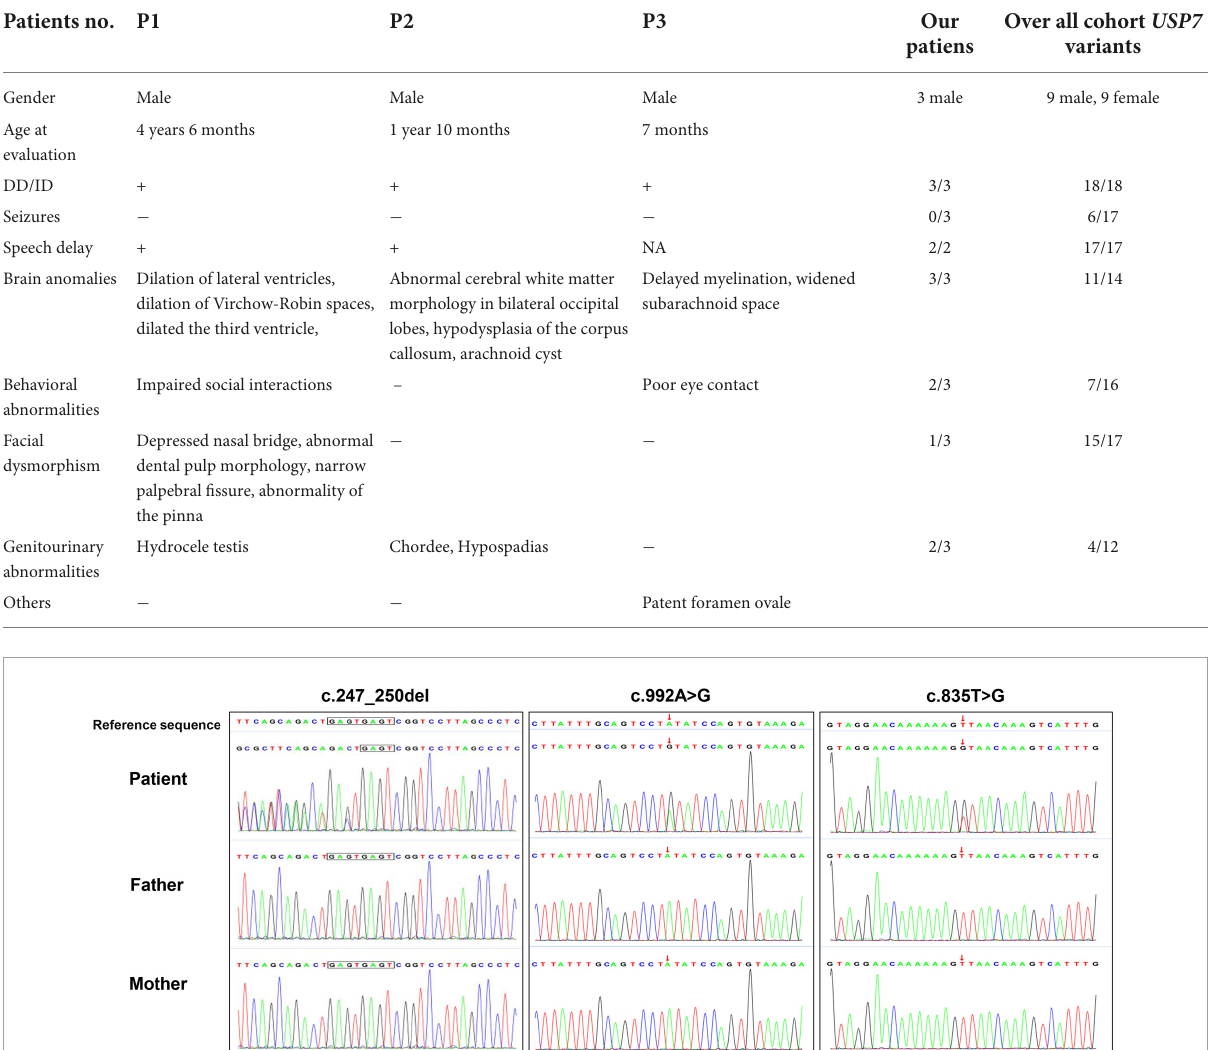
TABLE 2 The clinical phenotypes of the three patients.